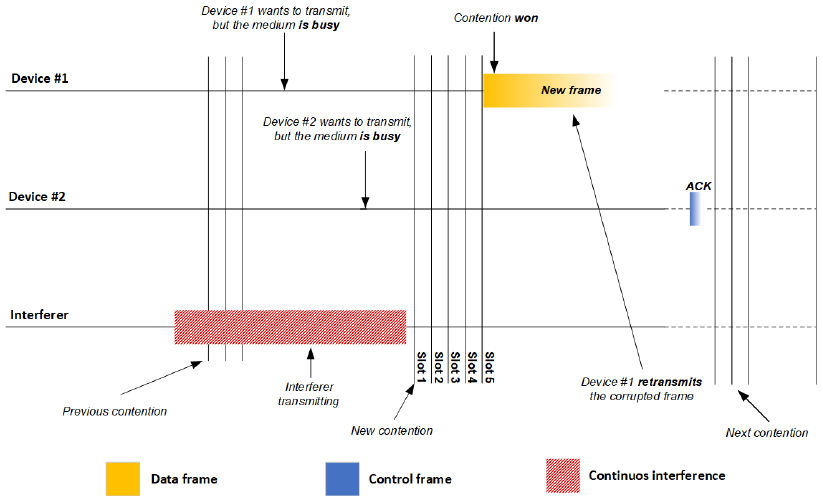
Figure 3. Illustration of CSMA/CA involving two devices and one interfering device on one chan- nel of an IEEE 802.11 network in the presence of severe interference. ACK, Acknowledgment Con- trol Frame.